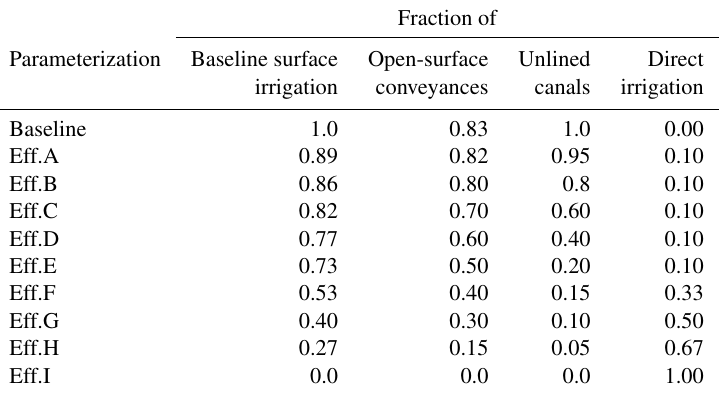
Table 1. Definition of efficiency